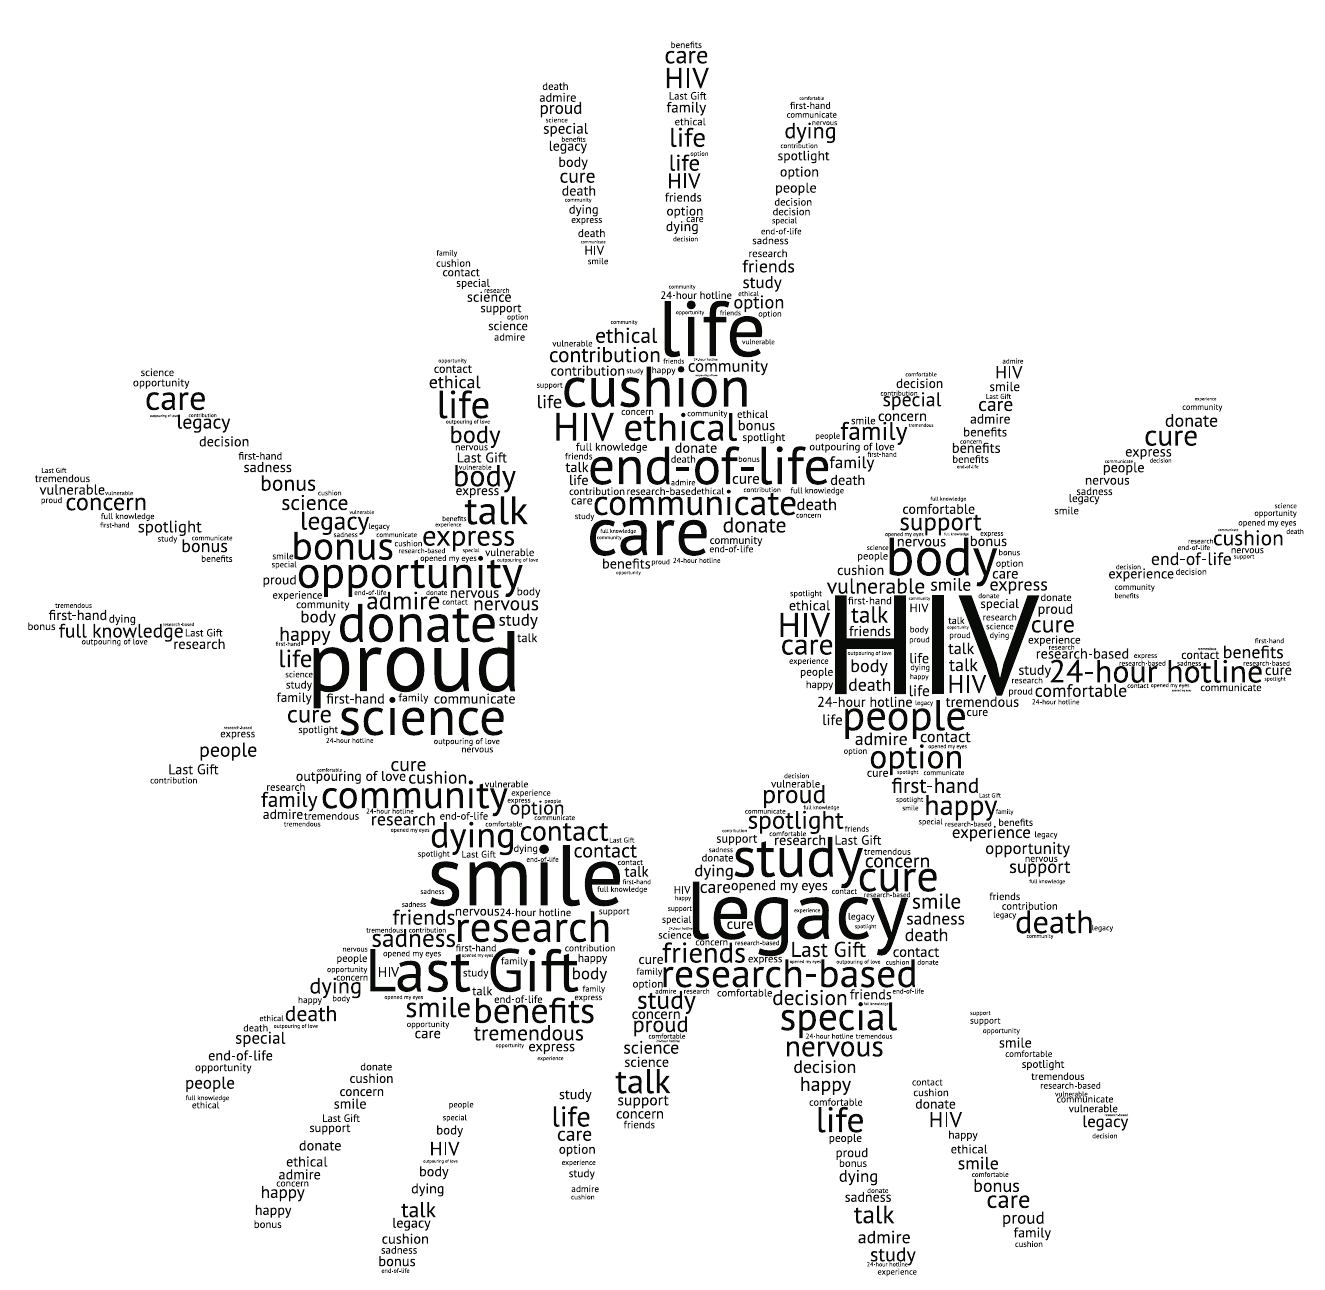
Fig 2. Word clouds from NOK quotes from discussions with NOK on HIV cure-related research at the EOL (San Diego, California, 2019).